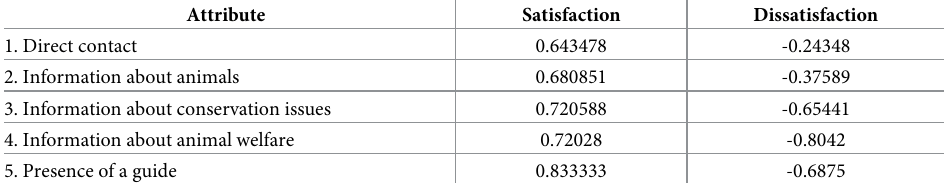
Table 6. Customer satisfaction and dissatisfaction coefficient (CS). The closer the satisfaction coefficient is to +1, the more the presence of the attribute influences respondents’ satisfaction. On the contrary, the closer the dissatisfac- tion coefficient is to -1, the more the absence of the attribute influences respondents’ dissatisfaction. If the CS is adja- cent to 0, it means that the attributes have a low influence on visitor satisfaction or dissatisfaction. Attribute